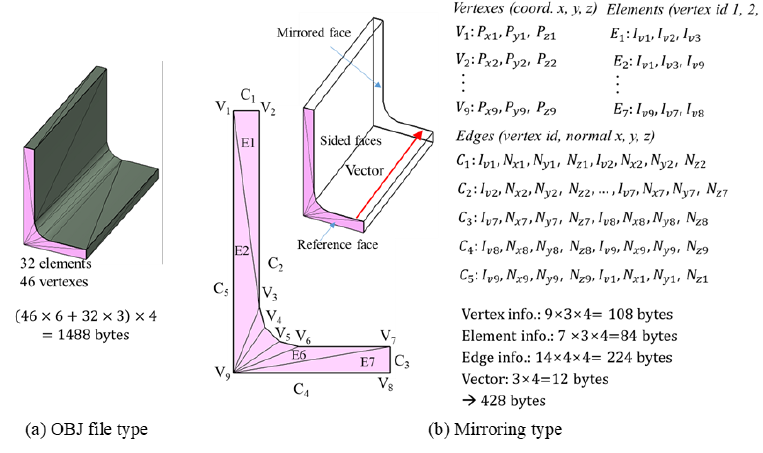
Figure 8. Data size minimization for L beam (32 elements, 46 vertexes).